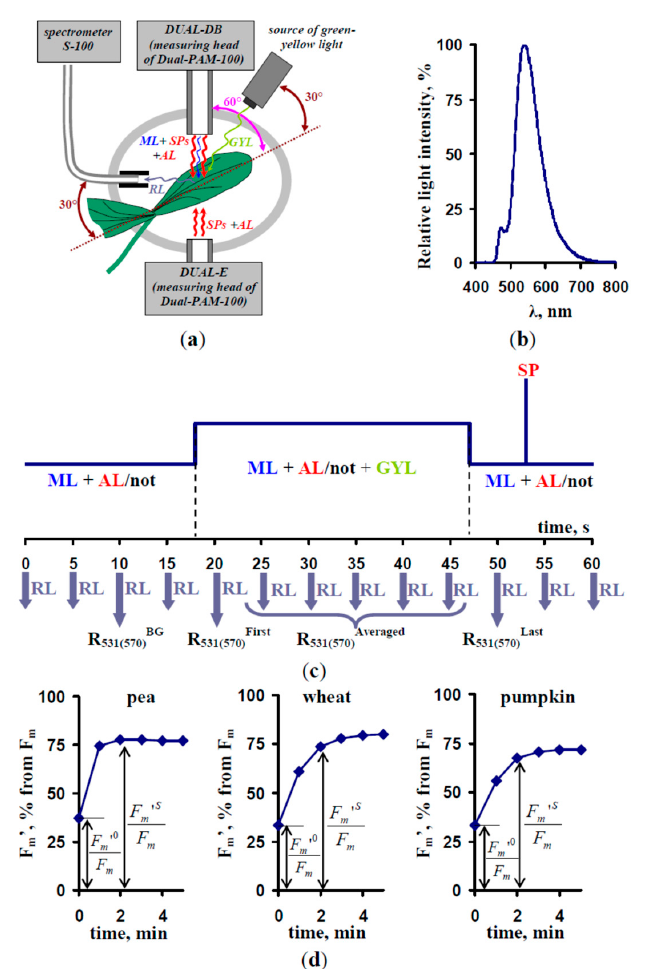
Figure 1. ( a ) Schema of measurements of the photochemical reflectance index (PRI) and photosynthetic parameters. Measuring light (ML) is standard pulses of the weak fluorescence measuring blue light (maximum intensity at 460 nm, 24 µ mol m − 2 s − 1 , 2.5 µ s pulse length). The red actinic light (AL) is maximum at 630 nm, 131, 344, 830, or 1599 µ mol m − 2 s − 1 , and pulses of the measuring green-yellow light (GYL) are maximum at 550 nm, 60, 120, 180, or 240 µ mol m − 2 s − 1 , 30 s. RL is the reflected light. Saturation pulses (SP) are maximum at 630 nm, 10,000 µ mol m − 2 s − 1 , 300 ms. DUAL-DB and DUAL-E are the detector and emitter blocks of the Dual-PAM-100 measuring system. S-100 is a spectrometer with a fiber-optic cable. The GYL source was a white TDS-P003L4U14 LED with yellow and yellow-green glass bandpass filters. The angle between the leaf surface and the direction of the GYL was about 30 ◦ ; the angle between the leaf surface and the input for RL was about 30 ◦ ; and the angle between the leaf surface and the direction of AL, SP, and ML was about 60 ◦ . ( b ) Light spectrum of the GYL. ( c ) Schema of the measurement of the reflected light at 531(570) nm ( R 531(570) ) at the pulse of GYL. R 531(570) was calculated as R 531(570) Averaged − R 531(570) BG or as R 531(570) First − R 531(570) BG , where R 531(570) BG is the absolute intensity of the reflected light at 531 (570) nm before the GYL pulse, R 531(570) First is the absolute intensity of the reflected light at 531 (570) nm at the initiation of this pulse, R 531(570) Averaged is the averaging of absolute intensities of the reflected light at 531 (570) nm during the GYL pulse, and R 531(570) Last is the absolute intensity of the reflected light at 531 (570) nm at the finalization of this pulse. ( d ) A dark relaxation of the maximum yield of fluorescence (F m (cid:48) ) in investigated plants after illumination by AL (1599 µ mol m − 2 s − 1 , 5 min). F m is the maximum yield of fluorescence after dark adaptation and F m (cid:48) 0 and F m (cid:48) S are the maximum yields of fluorescence before the finalization of illumination and at 2 min of dark relaxation, respectively.